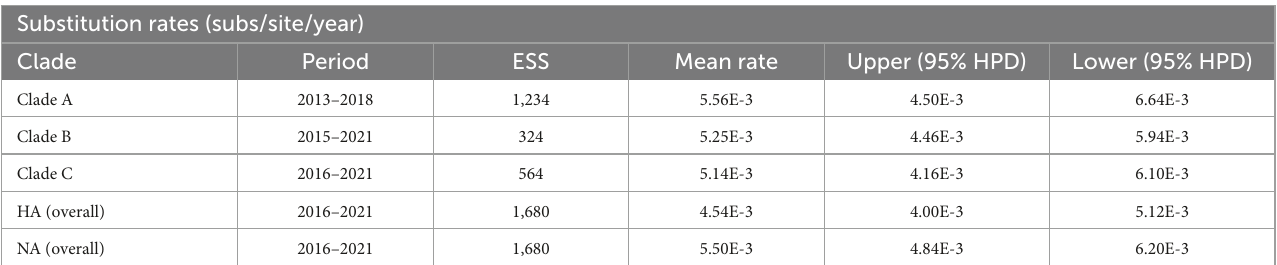
TABLE 1 Evolutionary rates of HA and NA genes from 2013 to